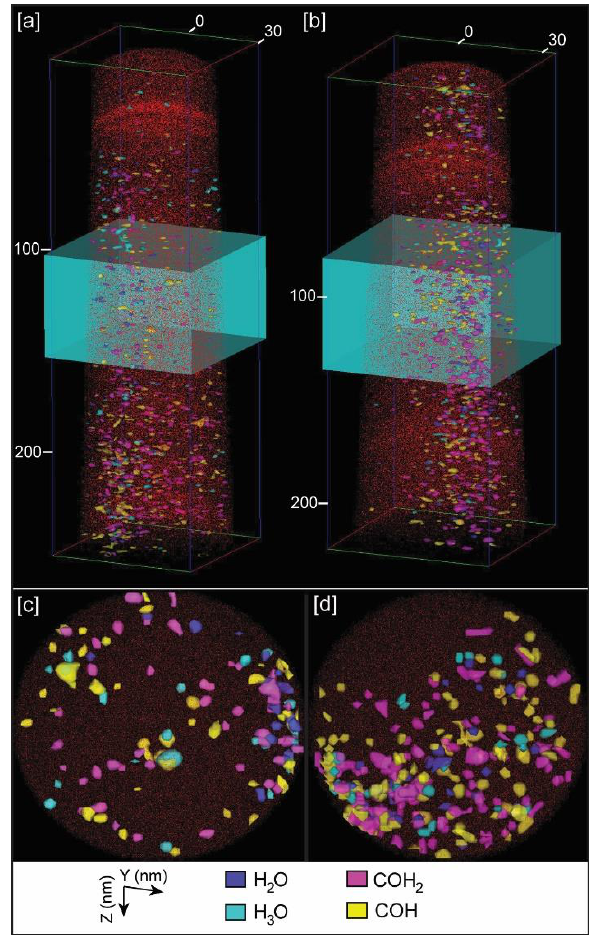
Figure 6. Example of APT 3D tip reconstructions: ( a ) Calcite tip with occluded chitin fragments at 0.12 mg/mL concentration of yatalase; ( b ) Calcite tip with occluded chitin fragments at 1.2 mg/mL concentration of yatalase; ( c ) Orthogonal projection view (along Z axis) of a slice of the tip within the blue box in ( a ); ( d ) Orthogonal projection view (along Z axis) of a slice of the tip within the blue box in ( b ). Notes: Dimensions, along Z and Y axes, are in nm; red dots correspond to Ca atoms; chitin fragments recognized by COH + COH 2+ , and associated water (H 2 O) and hydronium (H 3 O) molecules.